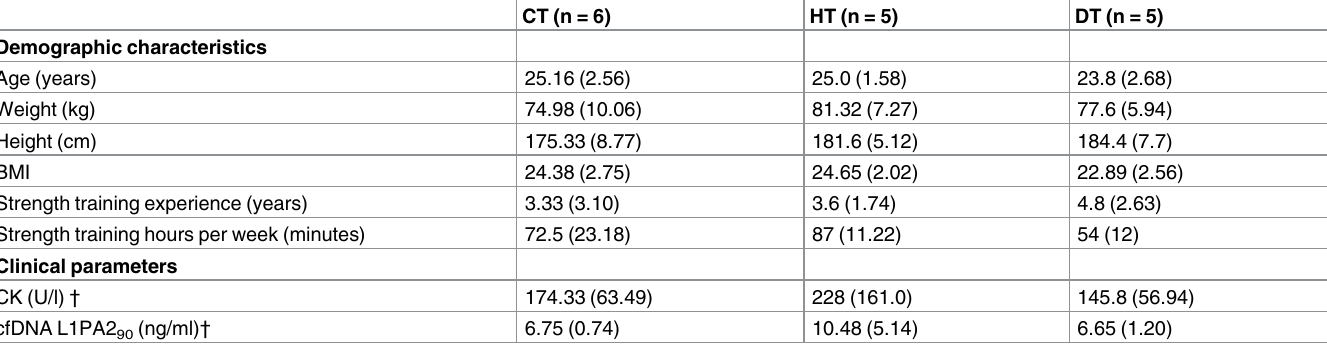
Table 2. Demographic characteristics and clinical parameters of study subjects at